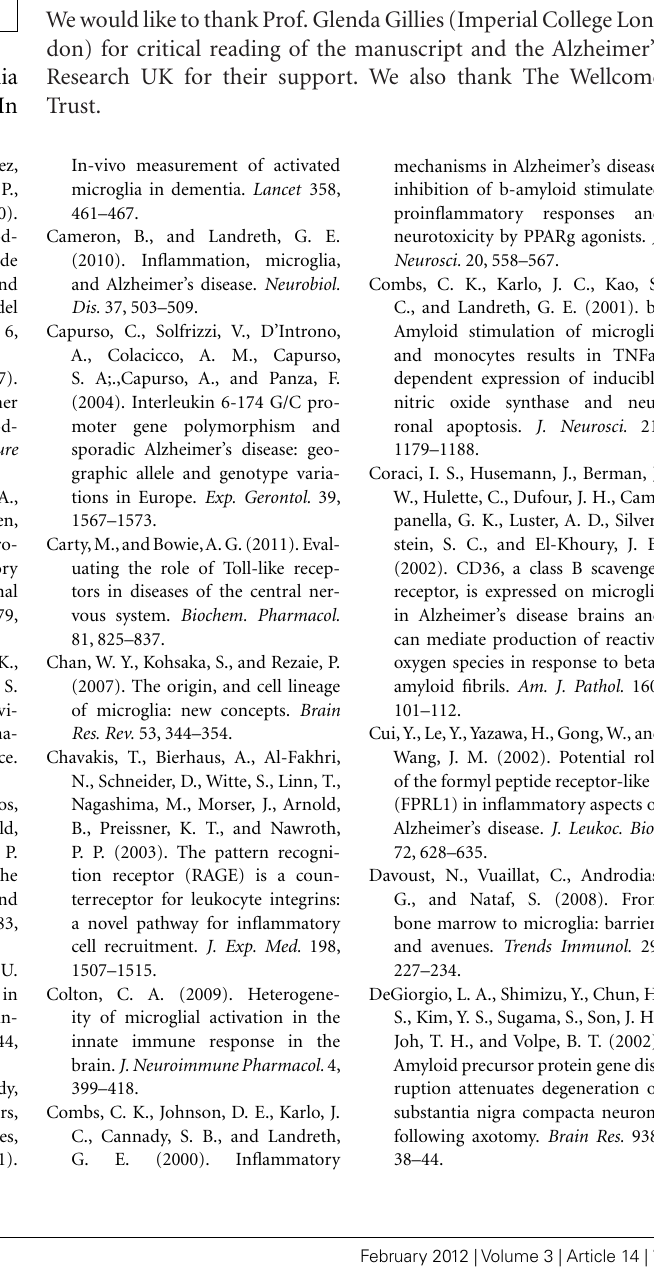
FIGURE 3 | Hypothetical annexinA1- FPRLI mechanism of action in microglia. Annexin A1 binds to FPRL-1 triggering an SOS signaling limiting microglia response to A β and preventing a constant uptake and apoptosis, altering microglia pro-inflammatory phenotype.